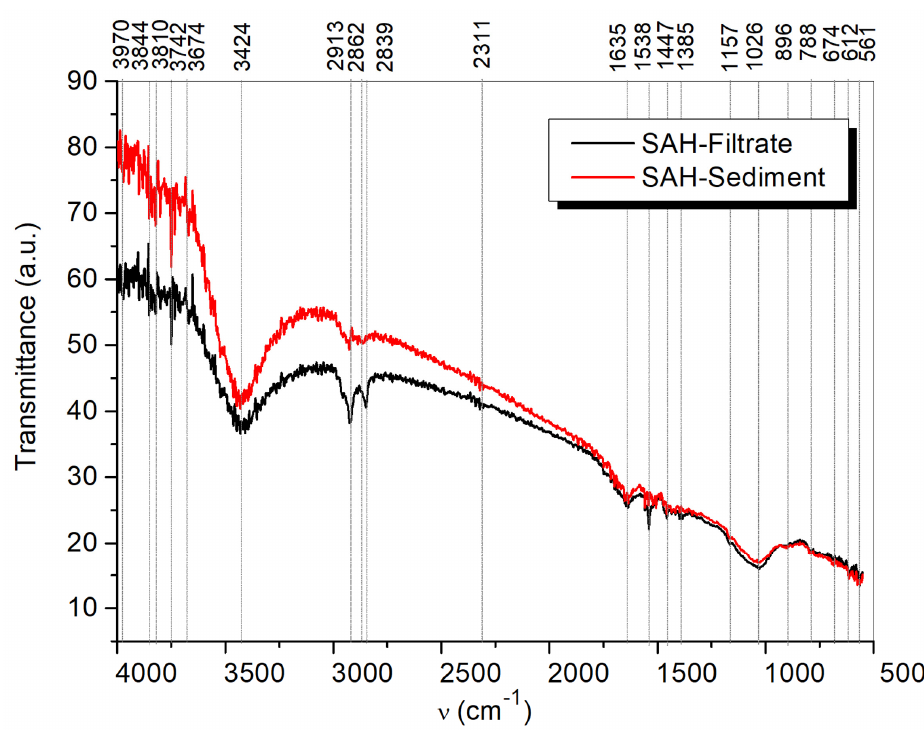
Figure 11. FTIR spectra of decanted solid phase from rainwater after Saharan dust episode.